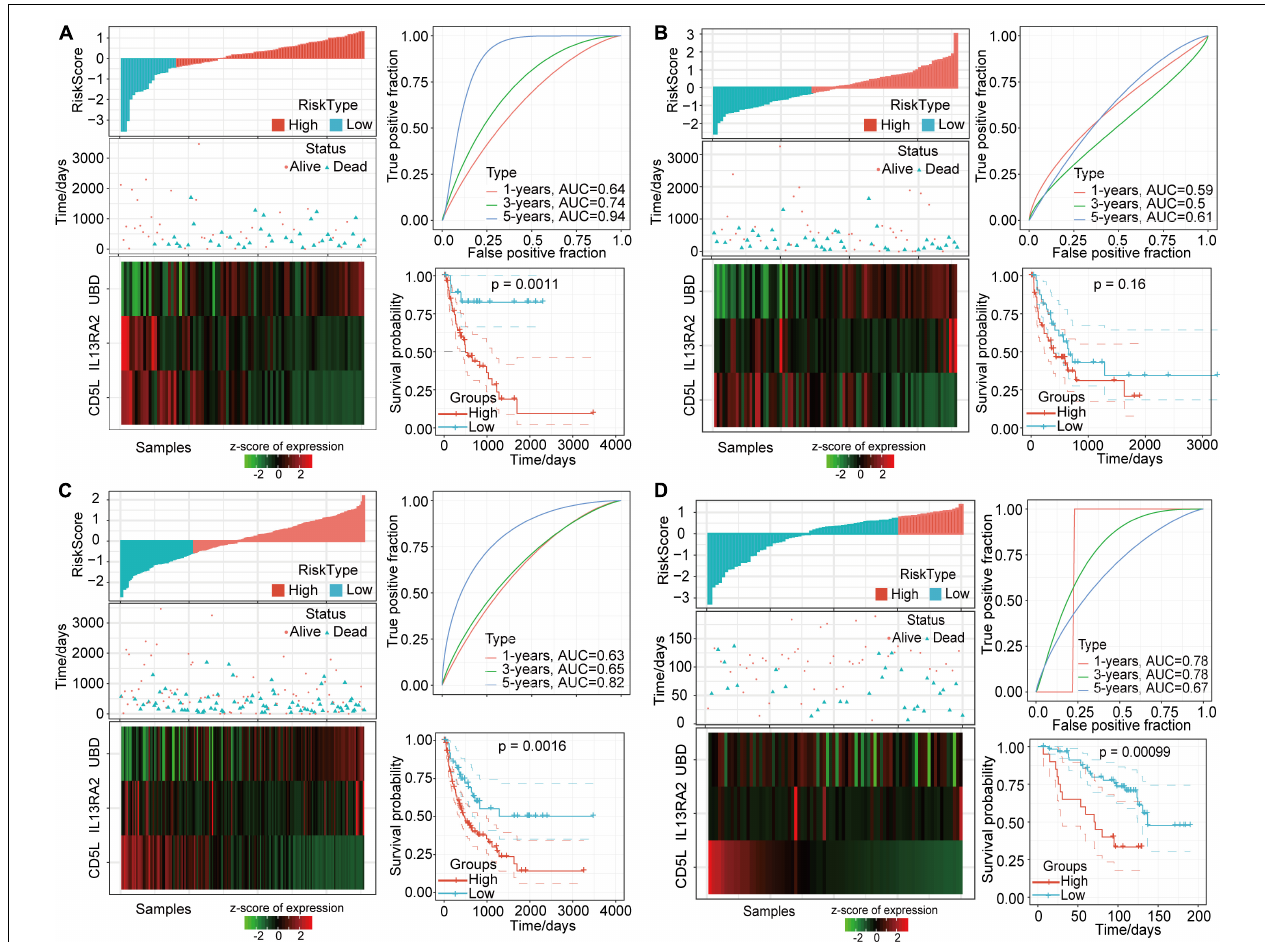
FIGURE 8 | Characteristics of prognostic gene signatures based on 3 DMEGs. (A) Training-set relationships between risk scores, survival status, and gene expressions for the three DMEGs and prognostic-signature ROC analysis and Kaplan-Meier curves. (B) Validation-set relationships between risk scores, survival status, and gene expressions for the three DMEGs and prognostic-signature ROC analysis and Kaplan-Meier curves. (C) The total TCGA-LIHC-set PD-1 negative samples relationships between risk scores, survival status, and gene expressions of the three DMEGs and prognostic-signature ROC analysis and Kaplan-Meier curves. (D) The GSE10141-set PD-1 negative samples relationships between risk scores, survival status, and gene expressions of the three DMEGs and prognostic-signature ROC analysis and Kaplan-Meier